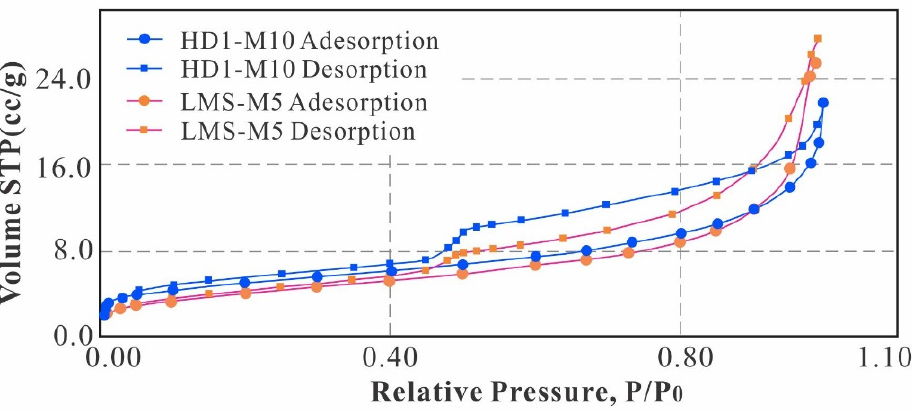
Figure 6. The adsorption and desorption curves of the typical marine and lacustrine shale samples based on the N 2 adsorption tests.